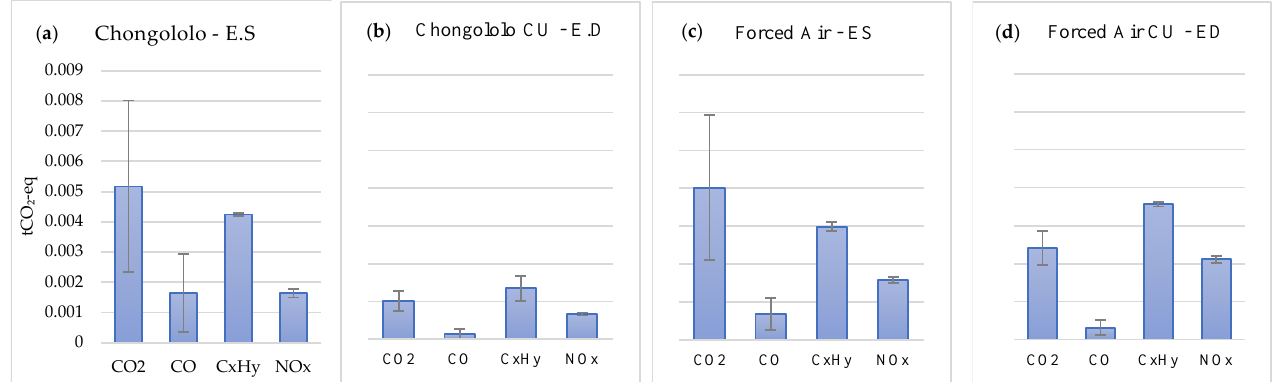
Figure 4. Emission factors for the Chongololo ( a and b ) and forced air ( c and d ) CUs, considering the firewood biomass of two forest species E. saligna (ES) and E. dunnii (ED).